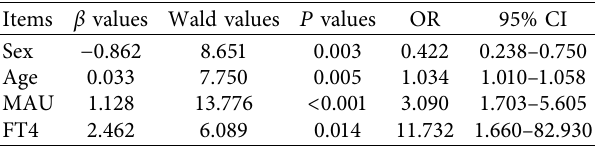
Table 2: Binary logistic regression analysis for predictors of thyroid nodule.